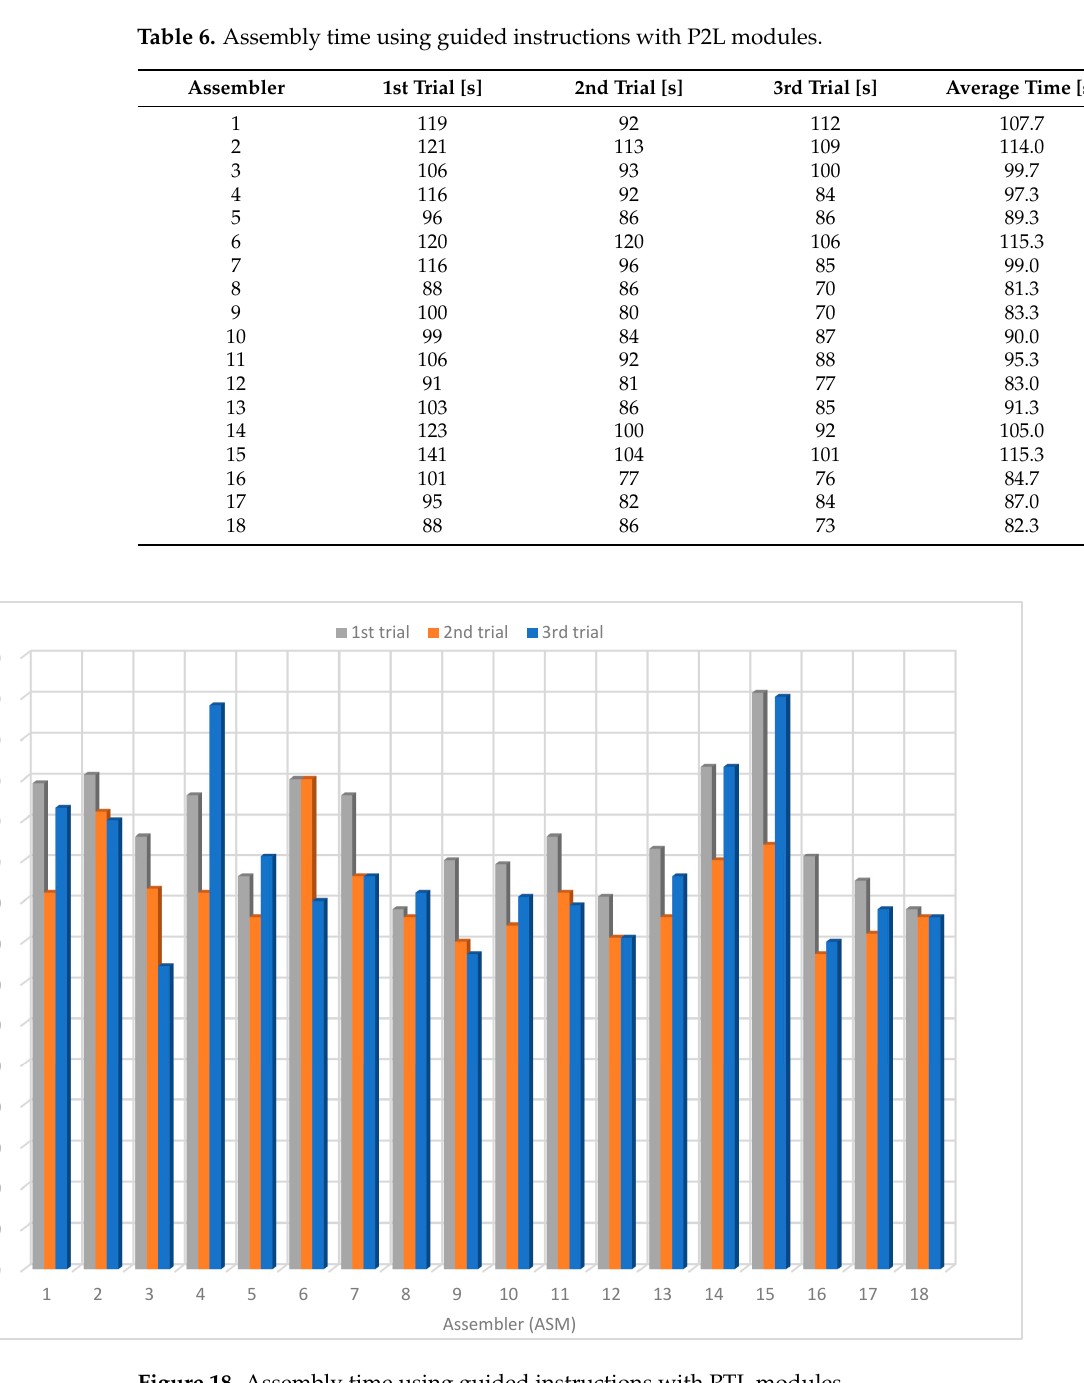
Figure 18. Assembly time using guided instructions with PTL modules.